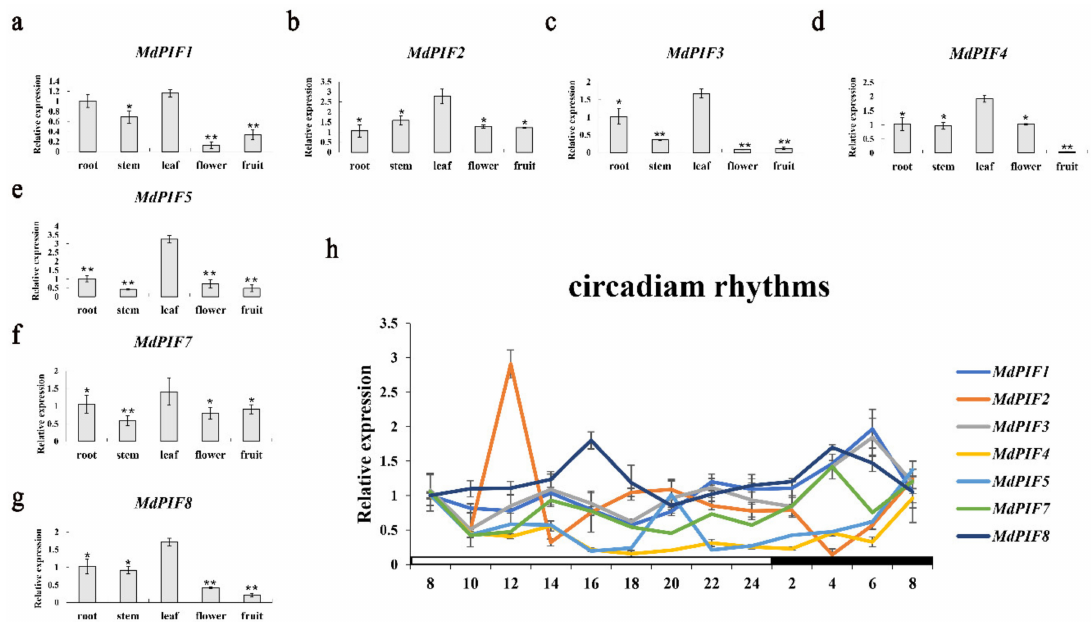
Figure 4. Expression profiles of the MdPIF genes. Expression profile of MdPIF1 ( a ), MdPIF2 ( b ), MdPIF3 ( c ), MdPIF4 ( d ), MdPIF5 ( e ), MdPIF7 ( f ), and MdPIF8 ( g ) in various apple tissues. 18S ribosomal